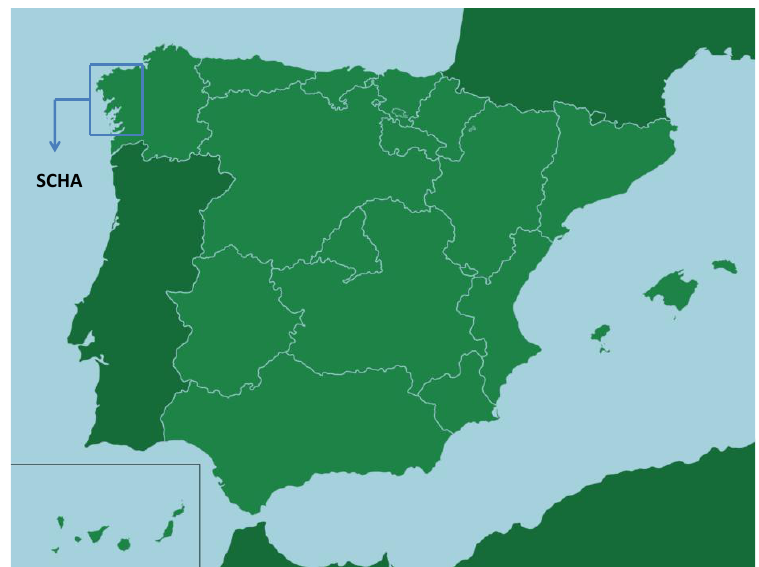
Figure 1. Health Area of Santiago de Compostela, in